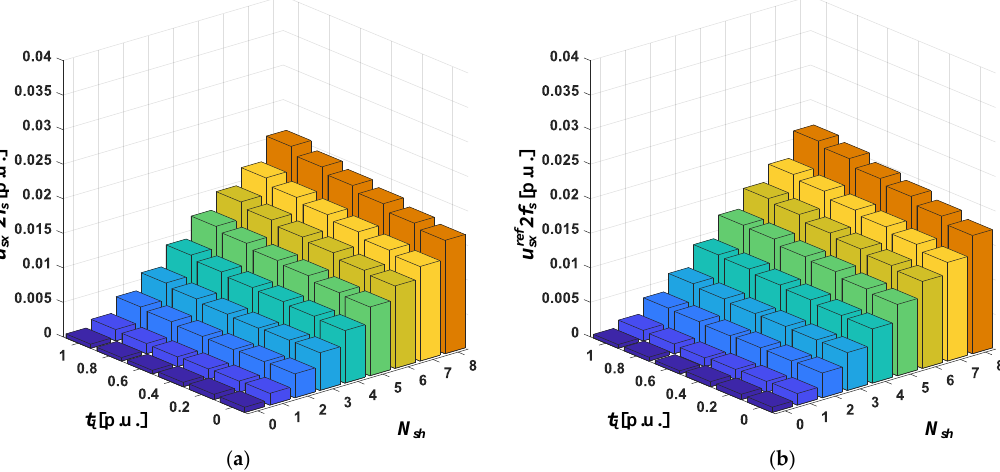
Figure 13. Amplitudes of f sh harmonic of u sx reference voltage component for di ff erent numbers of short-circuit turns and di ff erent load torques with ω m = 0.6 ω mN in the case of ( a ) speed measurement and ( b ) sensorless operation.